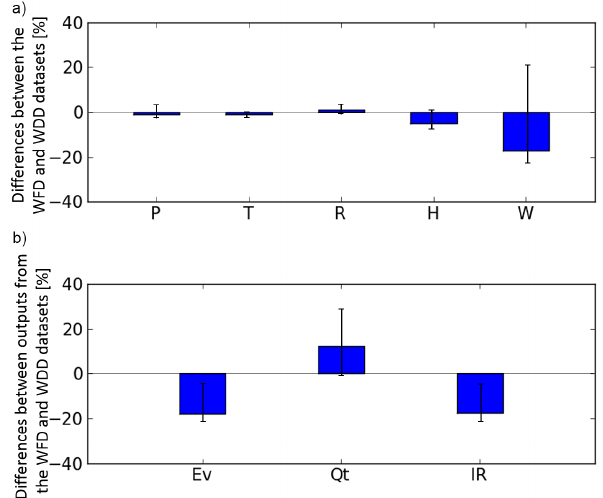
Figure 8. Global differences (%) in precipitation ( P ), tempera- ture ( T ), downward longwave and shortwave radiation ( R ), humid- ity ( H ), and wind speed ( W ) as simulation inputs for the three GCMs of the WDD data set compared to the WFD data set (a) , and global differences (%) in evapotranspiration (ET), runoff ( Q t ), and total irrigation requirement (IR) as simulation outputs for three GCMs of the WDD data set compared to those results using the WFD data set (b) . Blue bars and ranges show the average and the maximum and minimum for all the